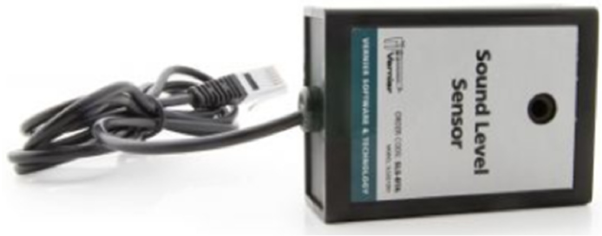
Figure 3. Sound/noise level sensor (source: www.vernier.com).